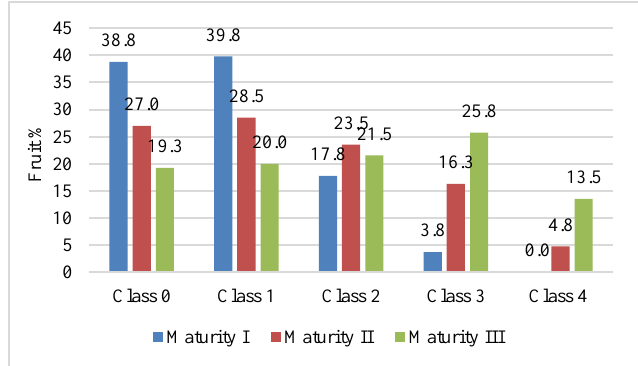
Figure 6. Effect of different harvest times (maturity classes) on Chilling injuries percentage of Flavor Cot apricot.